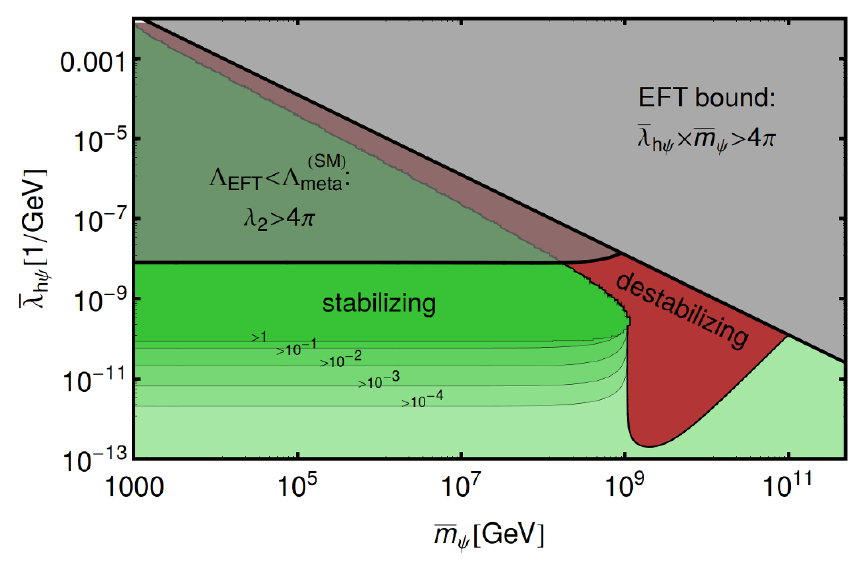
Figure 3 . Regions in the parameter space of dark matter mass (cid:22) m and portal coupling (cid:22) (cid:21) h , in which the Higgs potential is (de)stabilized. In the green (red) region the Higgs stability-bound is shifted to larger (smaller) values. The thin contours show the relative increase of the metastability scale, i.e., ((cid:3) (fdmSM) (cid:0) (cid:3) (SM) ) = (cid:3) (SM) . The shaded regions indicate where a perturbative EFT meta meta meta description, either in the fermionic sector or in the scalar sector breaks